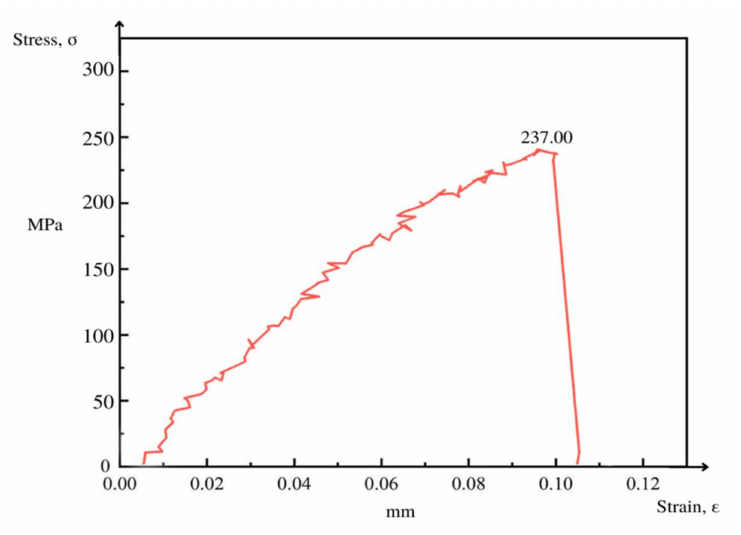
Figure 12. Tensile stress-strain